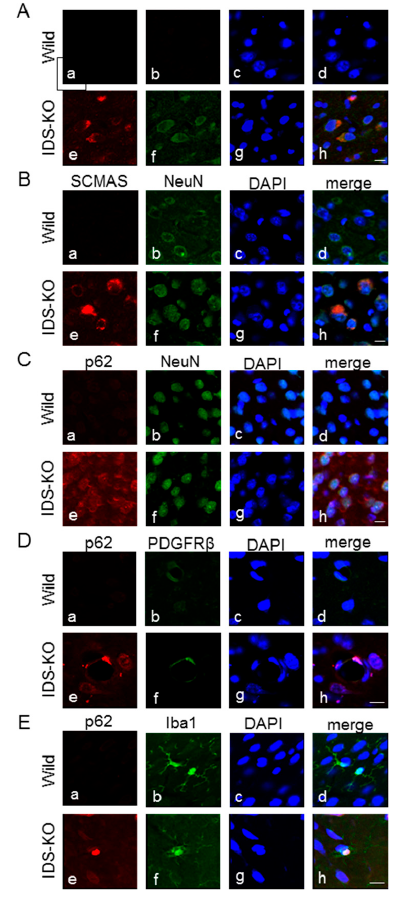
Figure 4. Double immunofluorescence staining with the indicated pairs of antibodies. Nuclei were counterstained with DAPI (blue). p62 (green) and SCMAS (red) immunopositivities were observed in the same cells of IDS-KO mice, confirming SCMAS as a marker of autophagy ( A : e – h ). Double immunofluorescence staining of SCMAS and NeuN (a neuronal marker) or of p62 and NeuN showed positive responses in the same cells ( B , C : e – h ). Double immunofluorescence staining of p62 and platelet-derived growth factor beta receptor (PDGFR- β ) (a pericyte marker) showed positive responses in the same cells ( D : e – h ). Double immunofluorescence staining of p62 and iba 1 (a microglial marker) showed positive reactions for both in the same cells ( E : e – h ). Specimens from wild-type mice were immunonegative for p62 and SCMAS ( A – E : a – d ). Bar = 1 µ